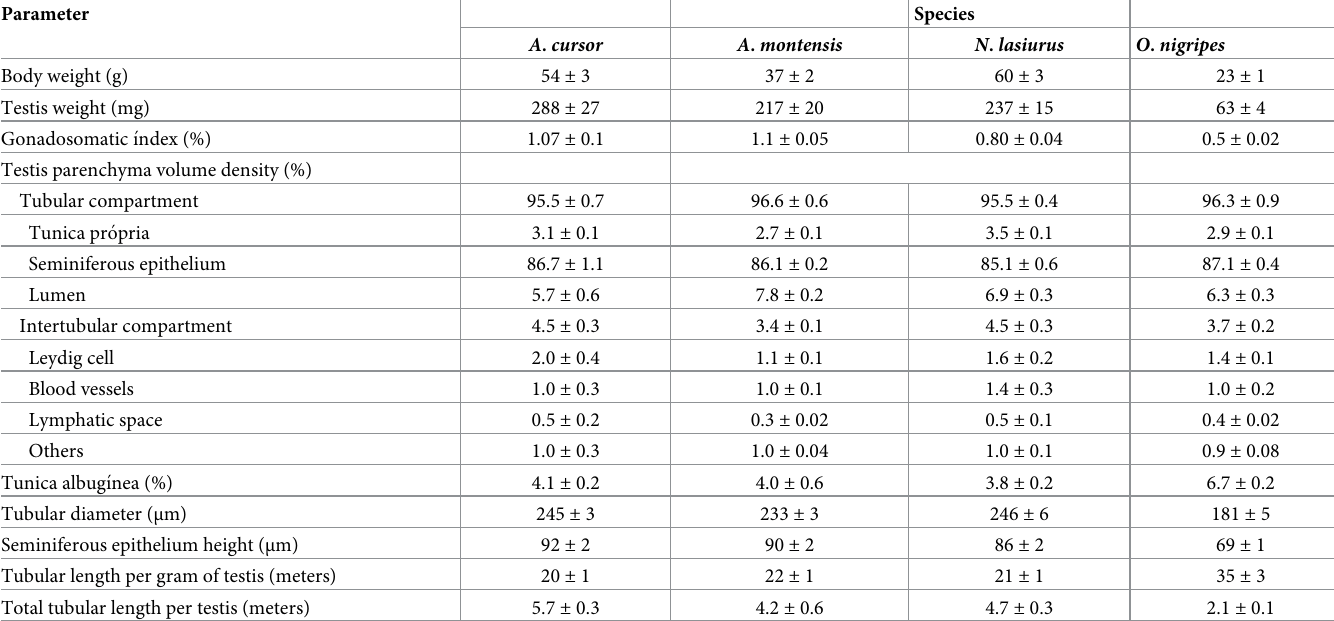
Table 1. Biometric and testis morphometric data in A . cursor , A . montensis , N . Lasiurus and O . nigripes (mean ±